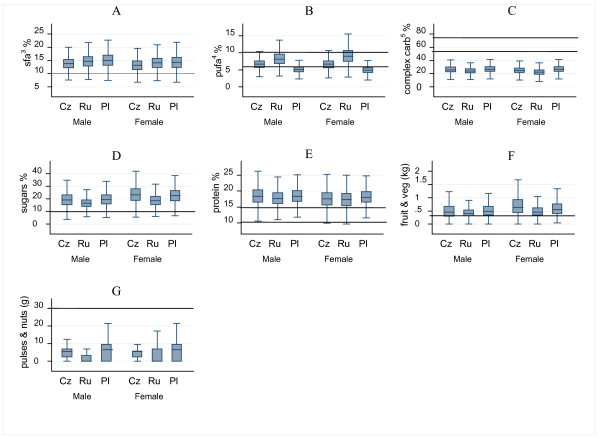
Median intakes and inter-quartile ranges1 of the Healthy Diet Indicator (HDI) components among subjects2. 1Percentages denote contribution to non-alcohol calorie intake; line across graph denotes WHO recommendation. 2 Czech Republic (CZ); Russia (RU); Poland (PL). 3saturated fatty acids; 4polyunsaturated fatty acids; 5complex carbohydrates.